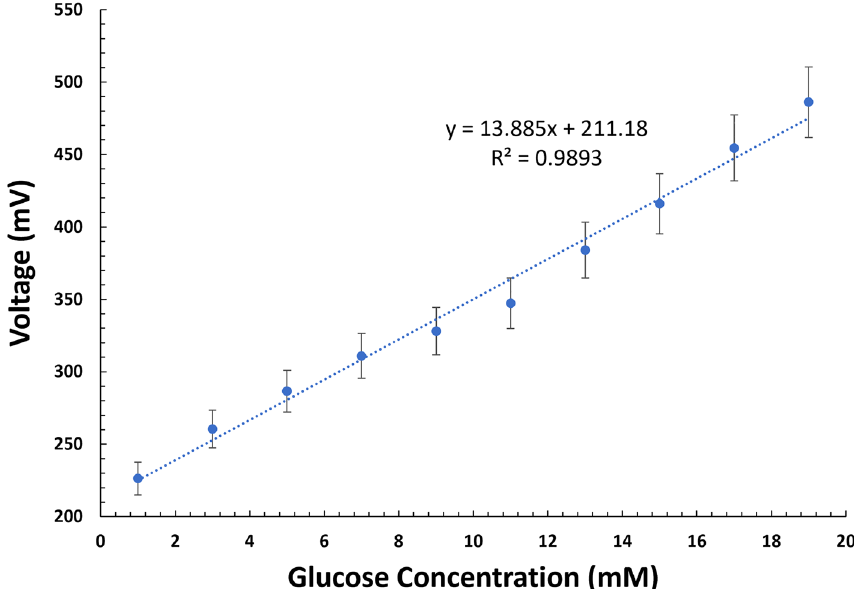
Figure 6. Glucose hybrid fuel cell voltage-glucose linear relationship.